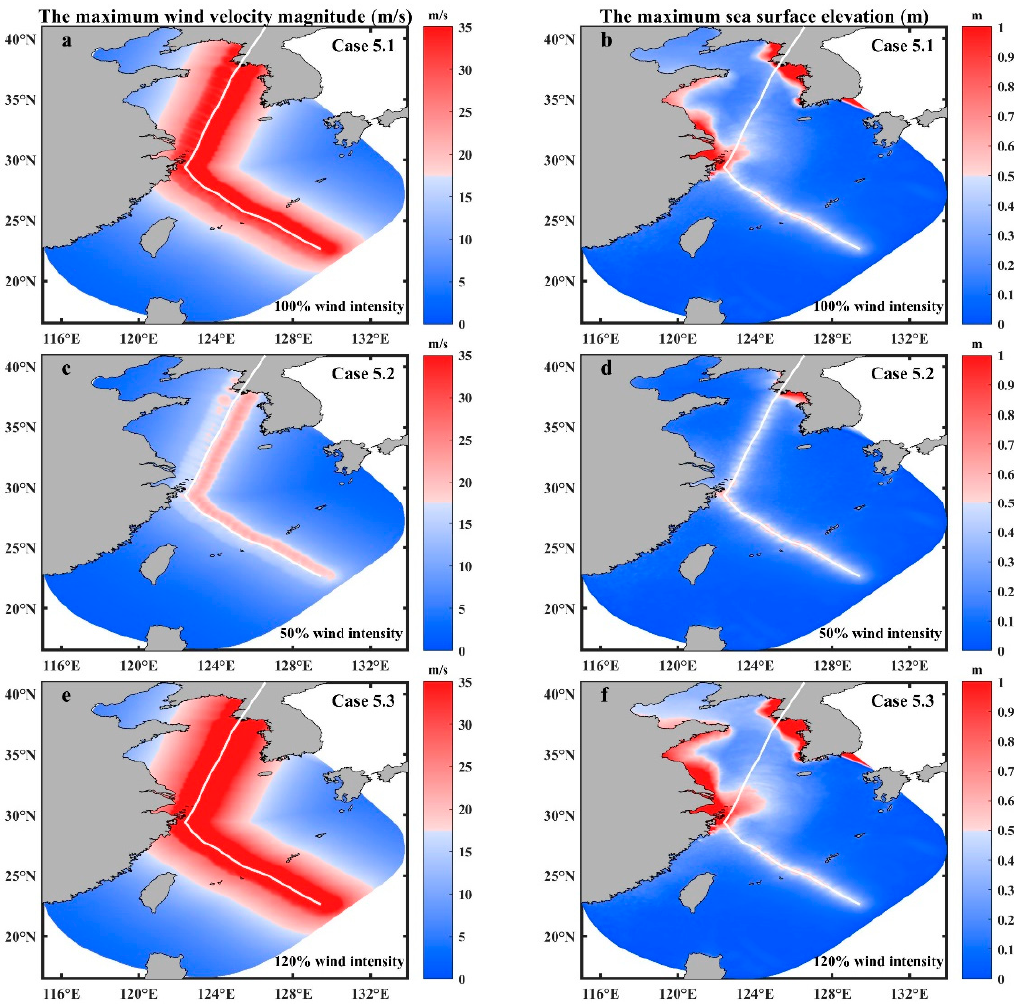
Figure 16. The maximum wind velocity magnitude in ( a ) Case 5.1, ( c ) Case 5.2, and ( e ) Case 5.3; The maximum sea surface elevation in ( b ) Case 5.1, ( d ) Case 5.2, and ( f ) Case 5.3. The white line represents the path of Chan-hom.